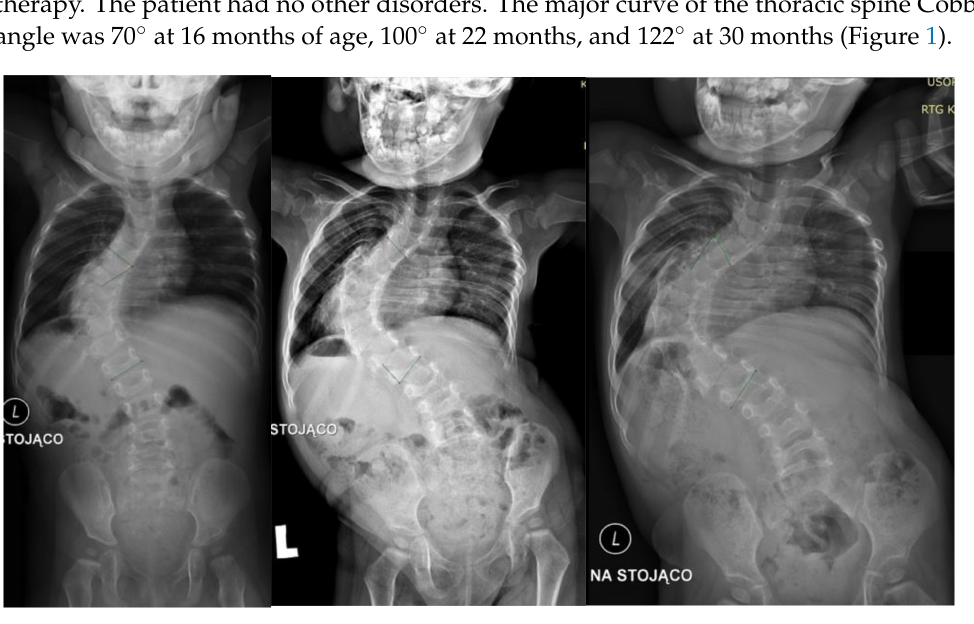
Figure 1. Showed standing: (from left to right) AP X-rays at 16 months old (70 degrees), 22 months old (100 degrees), and 30 months old (122 degrees).